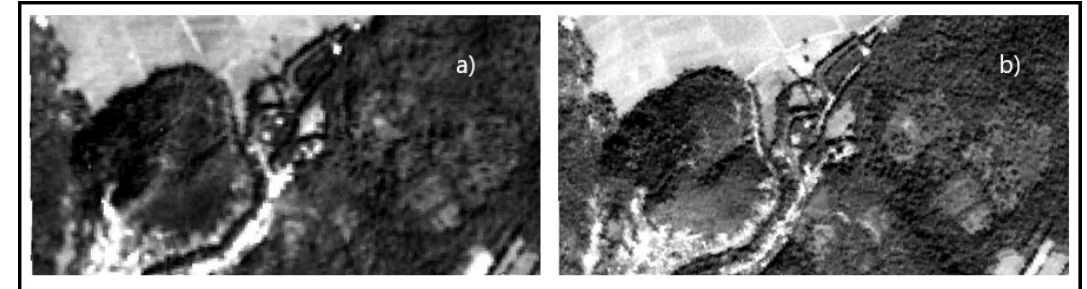
Figure 2. ( a ) SPOT-5 image with 10 m spatial resolution. ( b ) RapidEye image with 5 m spatial resolution.